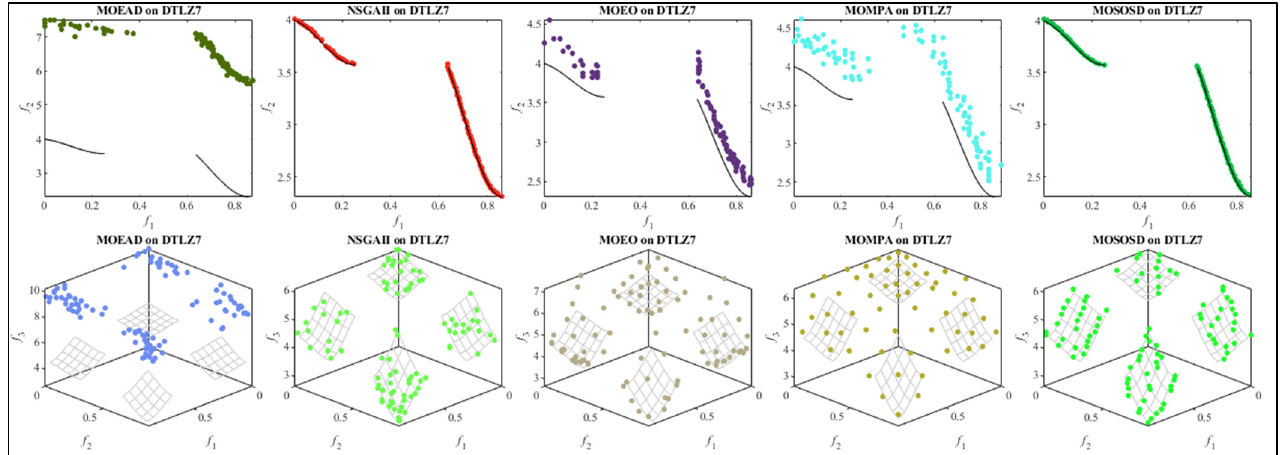
Figure 8. The Pareto front for DTLZ7 using various algorithms at 𝑀 = 2, 3 .